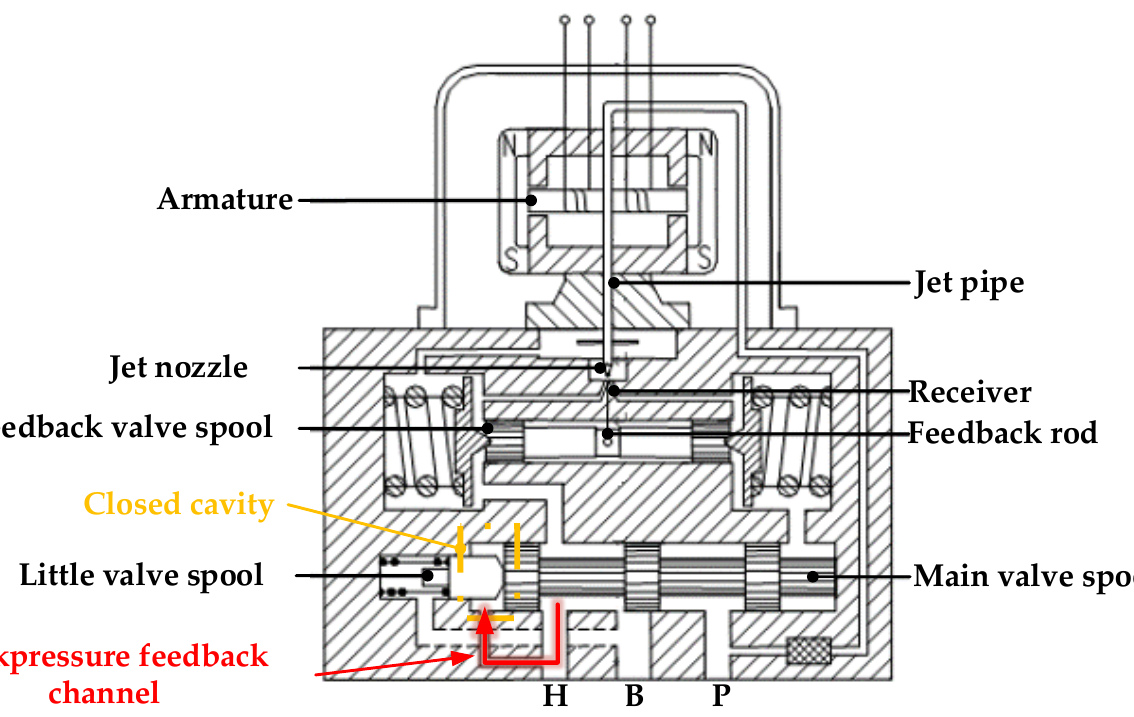
Figure 14. Pressure servo valve structure.